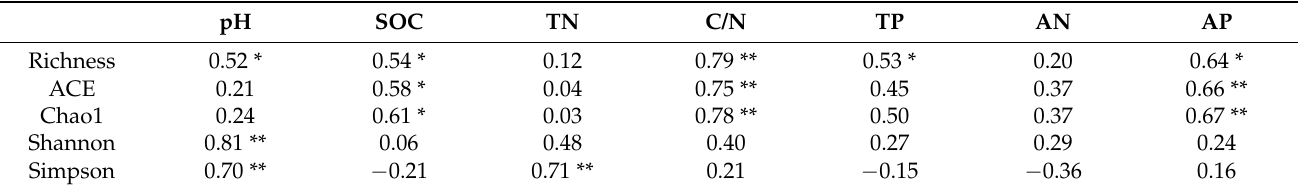
Table 4. Person’s rank correlation coefficients between fungal alpha-diversity and soil parameters.